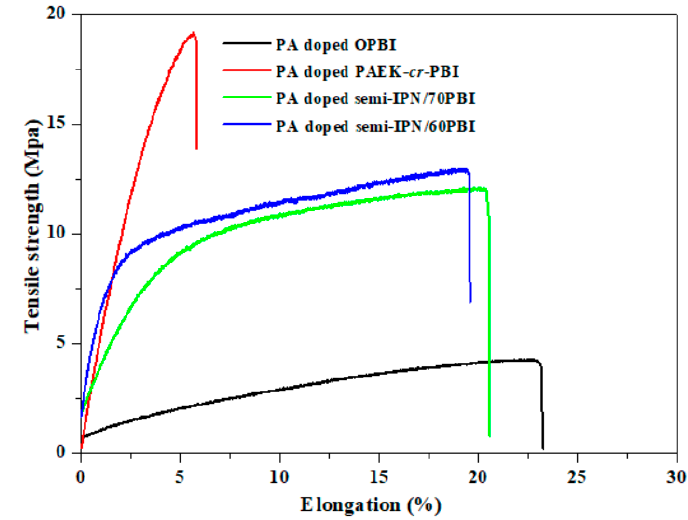
Figure 6. Stress-strain curves of PA doped membranes.